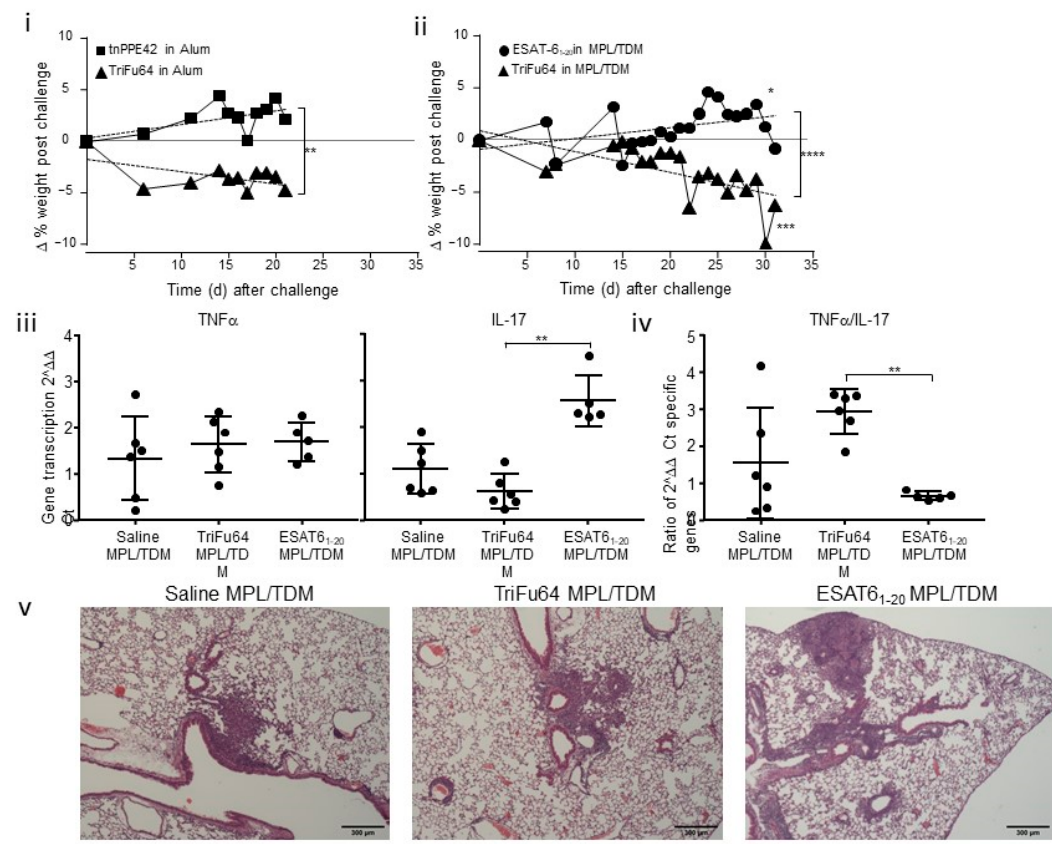
Figure 5. Vaccination with TriFu64 results in weight loss during the response to aerosol infection. Mice were vaccinated and then infected (as in Figure 3i,ii) and the weight of the mice relative to the weight on the day of challenge determined and baseline corrected against the sham values for each day. Vaccines used were tnPPE42 and TriFu64 in alum ( i ) and TriFu64 and ESAT6 1-20 ( ii – v ) in MPL/TDM/DDA (MPL/TDM). Alum data ( i ) is 1 of 1 experiments n = 4–10. MPL/TDM/DDA (MPL/TDM) data ( ii ) is 2 experiments combined n = 8–9 and ( iii – v ) one experiment n = 5. Linear regression analysis was used to determine if lines were significantly different from each other, or if lines were significantly different from zero (* p ≤ 0.05, ** p ≤ 0.01, *** p ≤ 0.001, **** p ≤ 0.0001). Lung tissue was processed for transcriptional activity using RT-PCR and the ^2 ΔΔ Ct value for TNF α and IL-17 determined ( iii ); the ratio of TNF α to IL-17 signal was determined within each sample ( iv ). Lung samples from each mouse were processed for histological analysis and representative 40X images are shown for each group ( v ). Significance of differences between means was determined by ANOVA and Kruskal Wallis comparison to the values from ESAT6 1-20 MPL/TDM vaccinated and infected mice (** p ≤ 0.01).